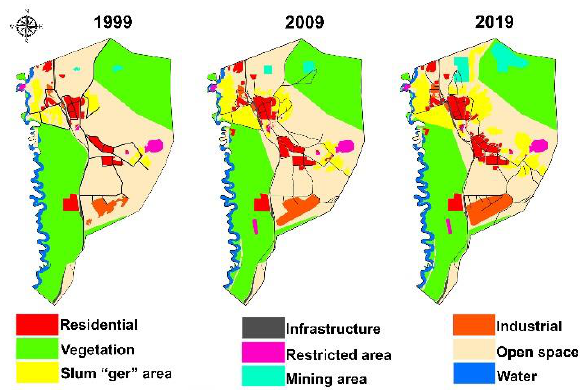
Figure 2. LUCC of Darkhan city by 1999, 2009 and 2019